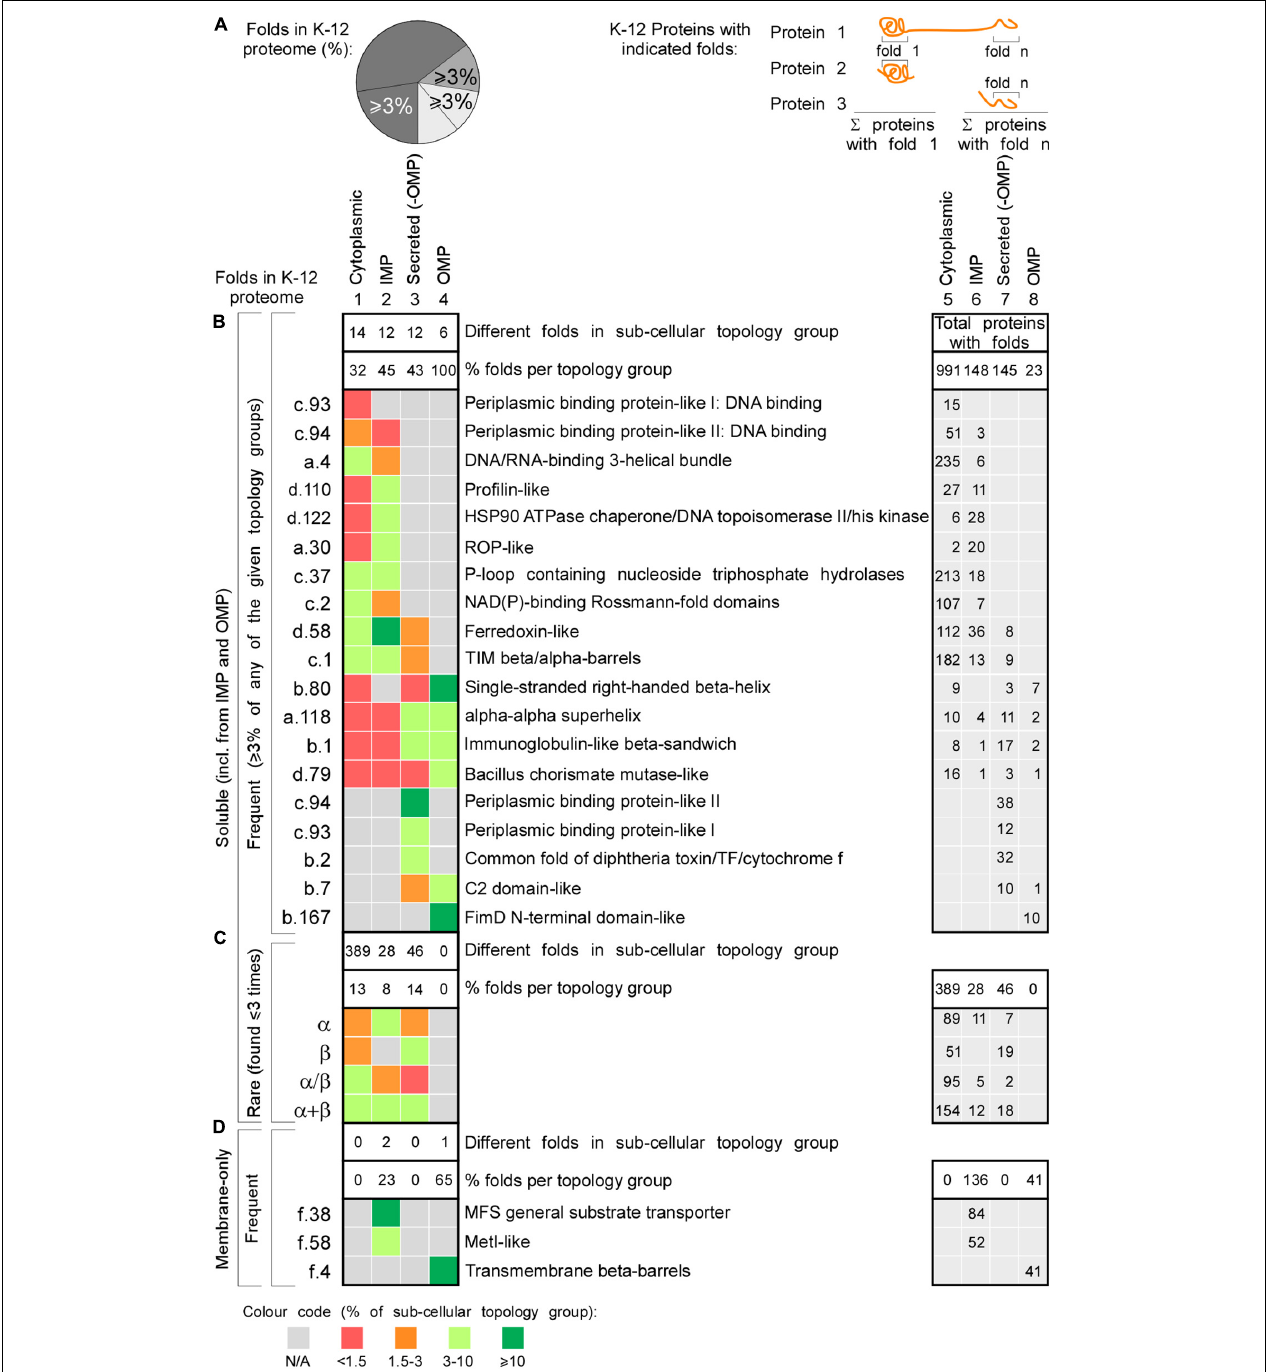
FIGURE 5 | Functional classes of the most frequent protein folds of K-12. Heat-map of occurrence of the most frequent and rare folds in different topology classes. (A) Left: cartoon representation of percentages depicted in the heat map ( B–D on the left). Percentage of folds that represent ≥ 3% of all the folds found in each topology class (cytoplasmome, IMP, secretome without OMPs or OMPs). Such folds are included in panels (B,D) . Right: cartoon representation of the numbers depicted in the table on the right. Each number is how many proteins were found having the respective fold. Empty cells when no proteins were found with that fold. (B) Nineteen soluble folds are shown that each represent ≥ 3% of folds found in a specific topology group. Left: fold abbreviation; right: full name. On the very right the sum of proteins having each fold is indicated. The absolute number of folds found in each subcellular topology group is noted in the upper white box and its corresponding percentage below it in the bottom white box. The upper white box on the right depicts the total protein sum in each topology. (C) The sum of four classes of folds that are rare and their distribution in the topology groups. (D) The membrane folds that represent minimum 3% of folds found in different topology groups. IMP, inner membrane proteins; OMP, outer membrane proteins; N/A, none found.